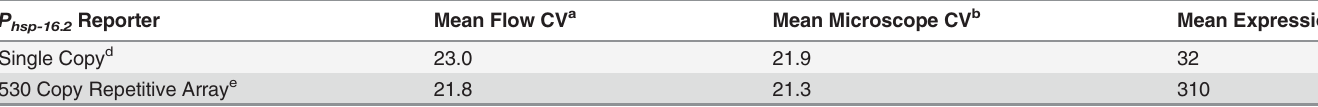
Table 2. Interindividual variation in expression of P hsp-16 . 2 - GFP reporter strains by flow and by image cytometry. P hsp-16 . 2